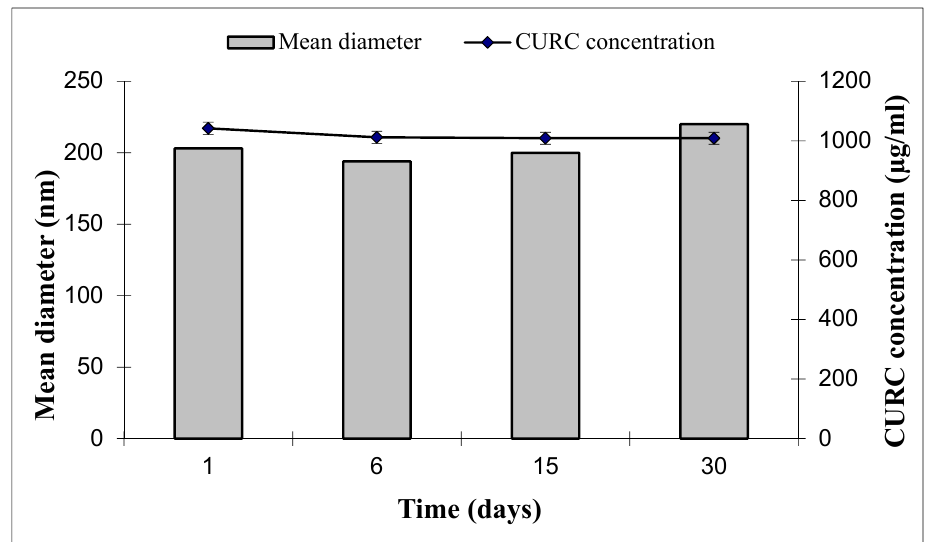
Figure 4. Stability of SLN-CURC in term of mean diameter (nm) and CURC concentration (µg/ml) over time after storage at 4 °C. Zeta potential (mV) was 1 day = − 10.02 mV ± 2.32; 6 days = − 13.57 mV ± 2.71; 15 days = − 18.86 mV ± 2.98; 30 days = − 19.53 mV ± 2.77. Also, CURC concentration in SLN suspensions decreases by approximately 3% during 30 day- storage remaining quite unmodified: this result is actually significant, as CURC entrapment in SLNs allowed, if not to hinder, at least to slow down CURC degradation.